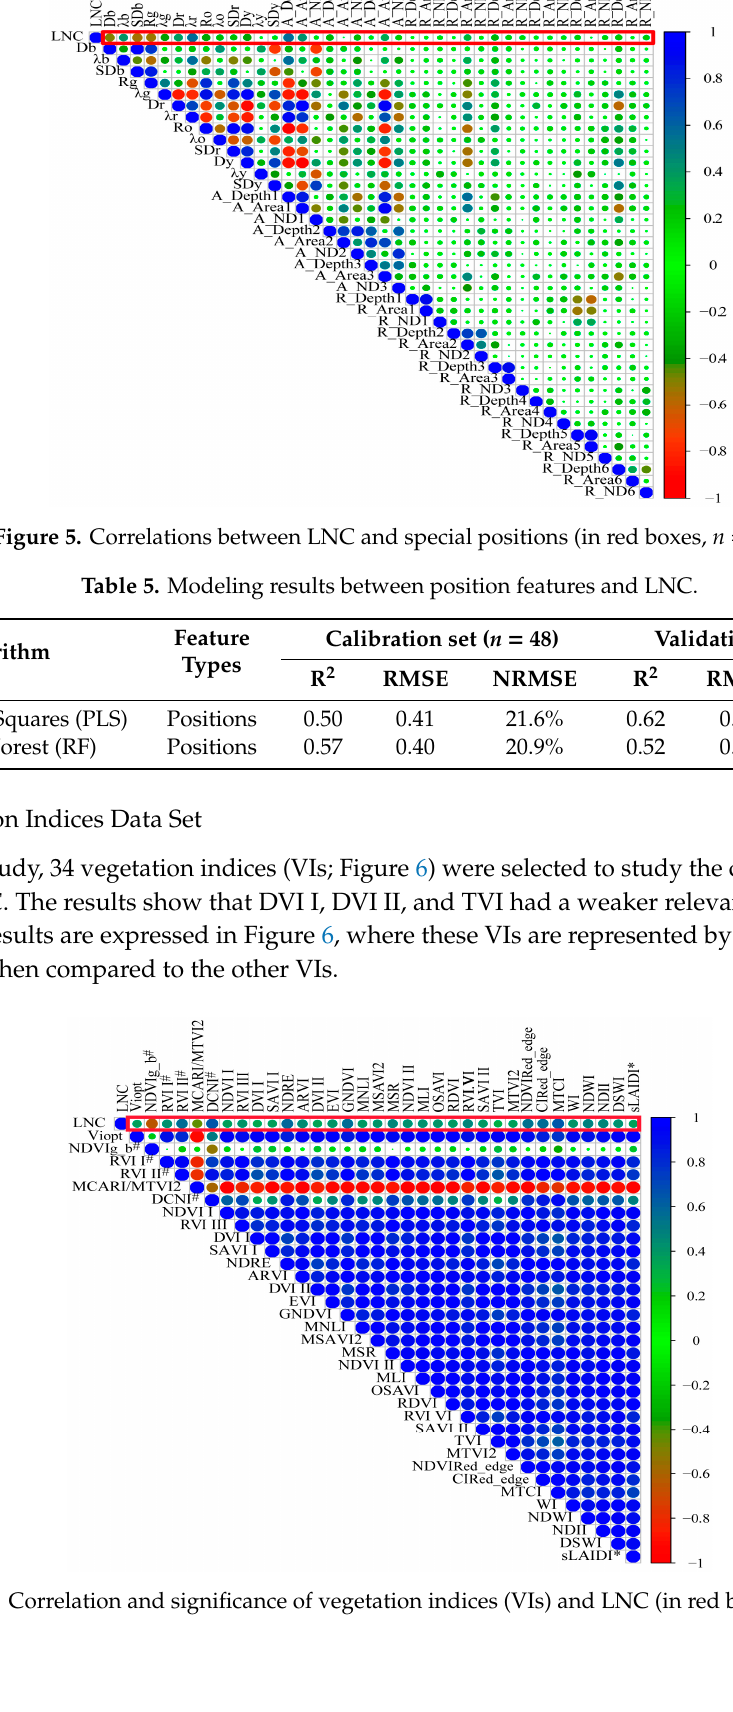
Figure 6. Correlation and significance of vegetation indices (VIs) and LNC (in red boxes, n = 48).